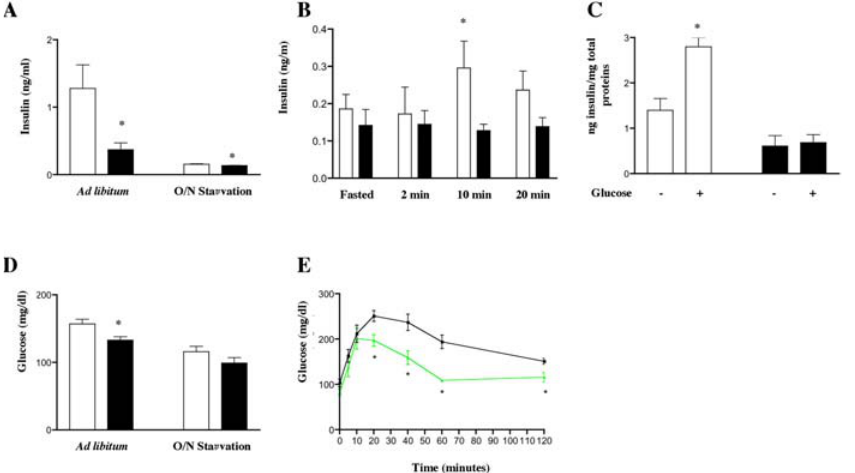
Figure 2. Sirt1 KO Mice Have a Lower Level of Insulin (A) Plasma insulin levels in wild-type (open bars) or Sirt1 KO mice (black bars) ad libitum or after O/N starvation ( n ¼ 12 wild-type, 11 KO, * p , 0.03 in ad libitum and O/N starvation mice, ANOVA). (B) Plasma insulin levels in Sirt1 KO mice (black bar) compared with wild-type mice (open bars) 2, 10, or 20 min after injection with glucose ( n ¼ 4 or 5, * p , 0.05 compared with wild-type, ANOVA). (C) Insulin secretion in islets isolated from wild-type (open bars) or Sirt1 KO mice (black bars) after induction by 20 mM glucose for 1 h ( n ¼ 4, * p , 0.005 in wild-type, ANOVA). (D) Glucose levels in wild-type (open bars) and Sirt1 KO (black bars) mice ( n ¼ 12 wild-type, 11 KO, * p , 0.03 ad libitum, ANOVA). (E) Glucose tolerance tests in wild-type (black) and Sirt1 KO (green) mice ( n ¼ 6, * p , 0.05 at 20, 40, 60, and 120 min). DOI: